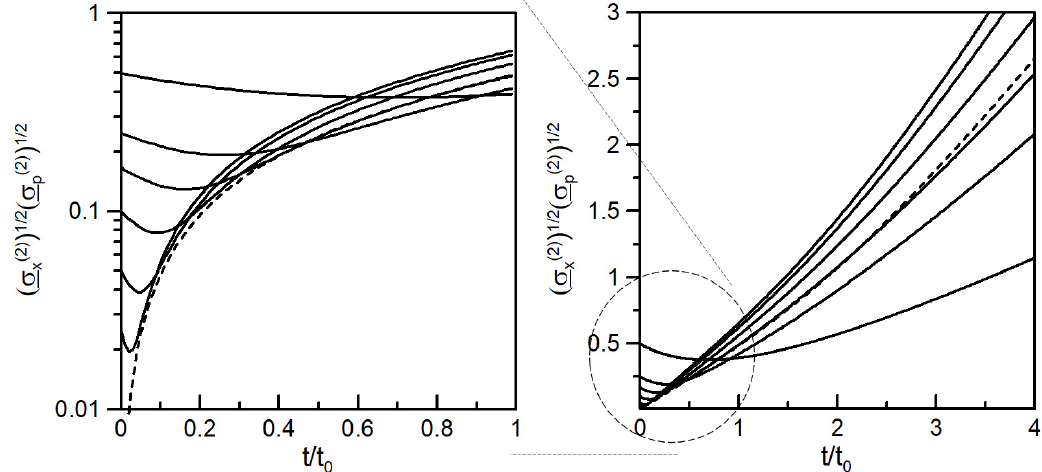
( 2 ) ( τ )) 1/2 ( σ ( 2 ) ( τ )) 1/2 for the fluid at the boundary between Figure 8. The time evolutions of the product ( σ x p liquid and gas ( α A = 1) are shown on the right panel. A zoom for the early stage of evolution is shown in the left panel in logarithmic scale. Six solid curves represent the results for R e = 1, 2, 3, 5, 10 and 20. For the sake of comparison, the graphs for the ideal fluid are shown by dotted lines. Minima at the solid curves move up and to the right as R e decreases. The solid line for R e = 3 and the dotted line are almost coincide. The solid curves for R e ≥ 5 stay above the dotted